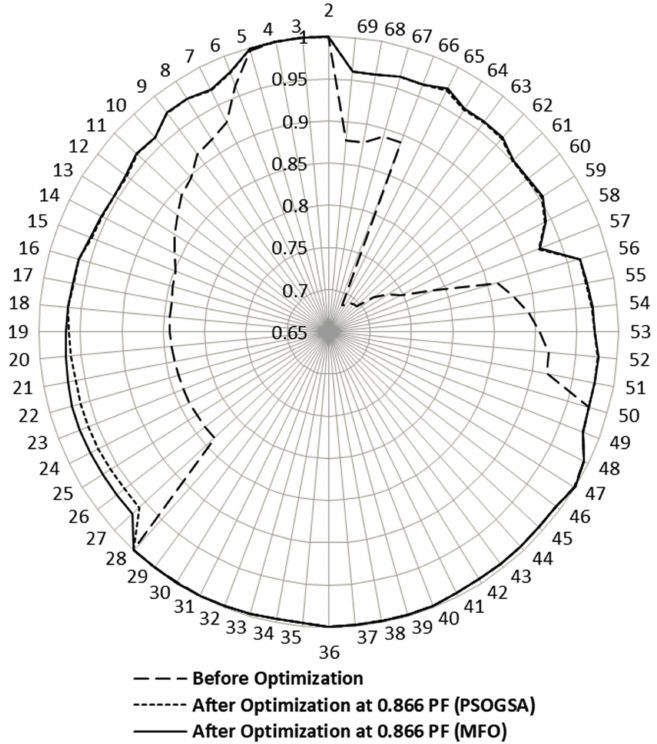
Figure 25. The impact of compensated devices on VSI profile for 69-bus IEEE system at 0.866